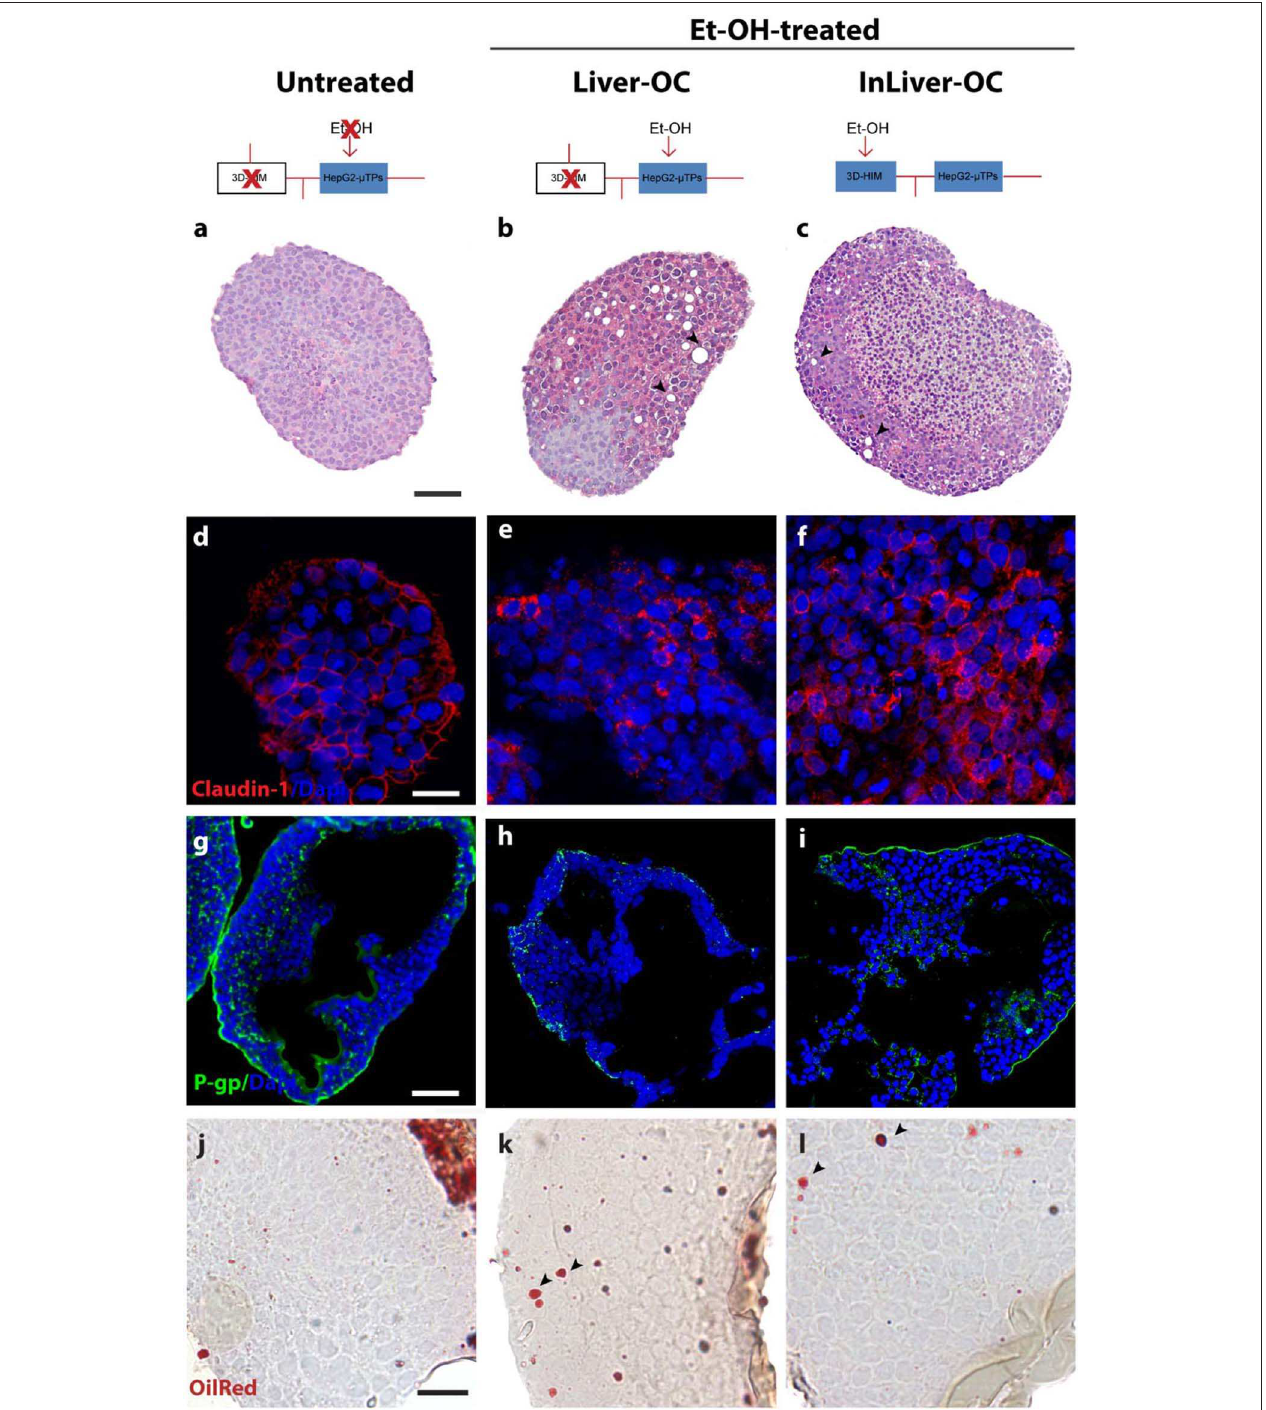
FIGURE 7 | Protective role of 3D-HIM on Et-OH-induced liver cytotoxicity. Schematic representation of Et-OH administration in different configurations [untreated (a) , Et-OH-treated Liver-OC (b) and Et-OH-treated InLiver-OC (c) ]; representative images of the histological analysis display H&E staining of untreated (a) Et-OH-treated Liver-OC (b) and Et-OH-treated InLiver-OC (c) ; black arrowheads indicate the lipid accumulation; scale bar 100 µ m; representative immunofluorescence of tight junction marker Claudin-1 of untreated (d) , Et-OH-treated Liver-OC (e) and Et-OH-treated InLiver-OC (f) ; scale bar 50 µ m; immunofluorescent staining of the protein transporter P-gp of untreated (g) , Et-OH-treated Liver-OC (h) and Et-OH-treated InLiver-OC (i) ; scale bar 100 µ m. Oil red staining reveals the lipid drop (black arrowheads) on untreated (j) , Et-OH-treated Liver-OC (k) and Et-OH-treated InLiver-OC (l) ; scale bar 50 µ m. All the experiments were performed in triplicate ( n = 3); values represent the mean and the standard